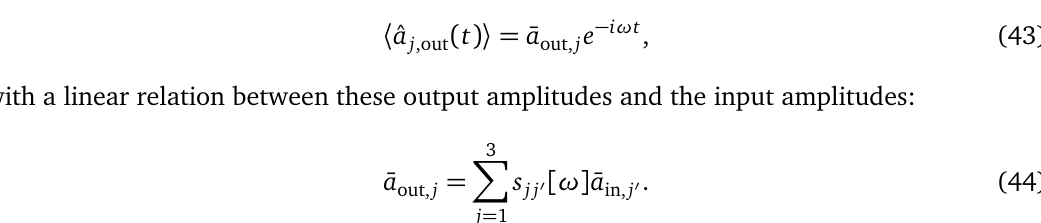
Figure 2: Schematic showing a single cavity (lowering operator ˆ a input-output waveguide or transmission line. ˆ a and noise incident on the cavity, whereas ˆ a noise leaving the